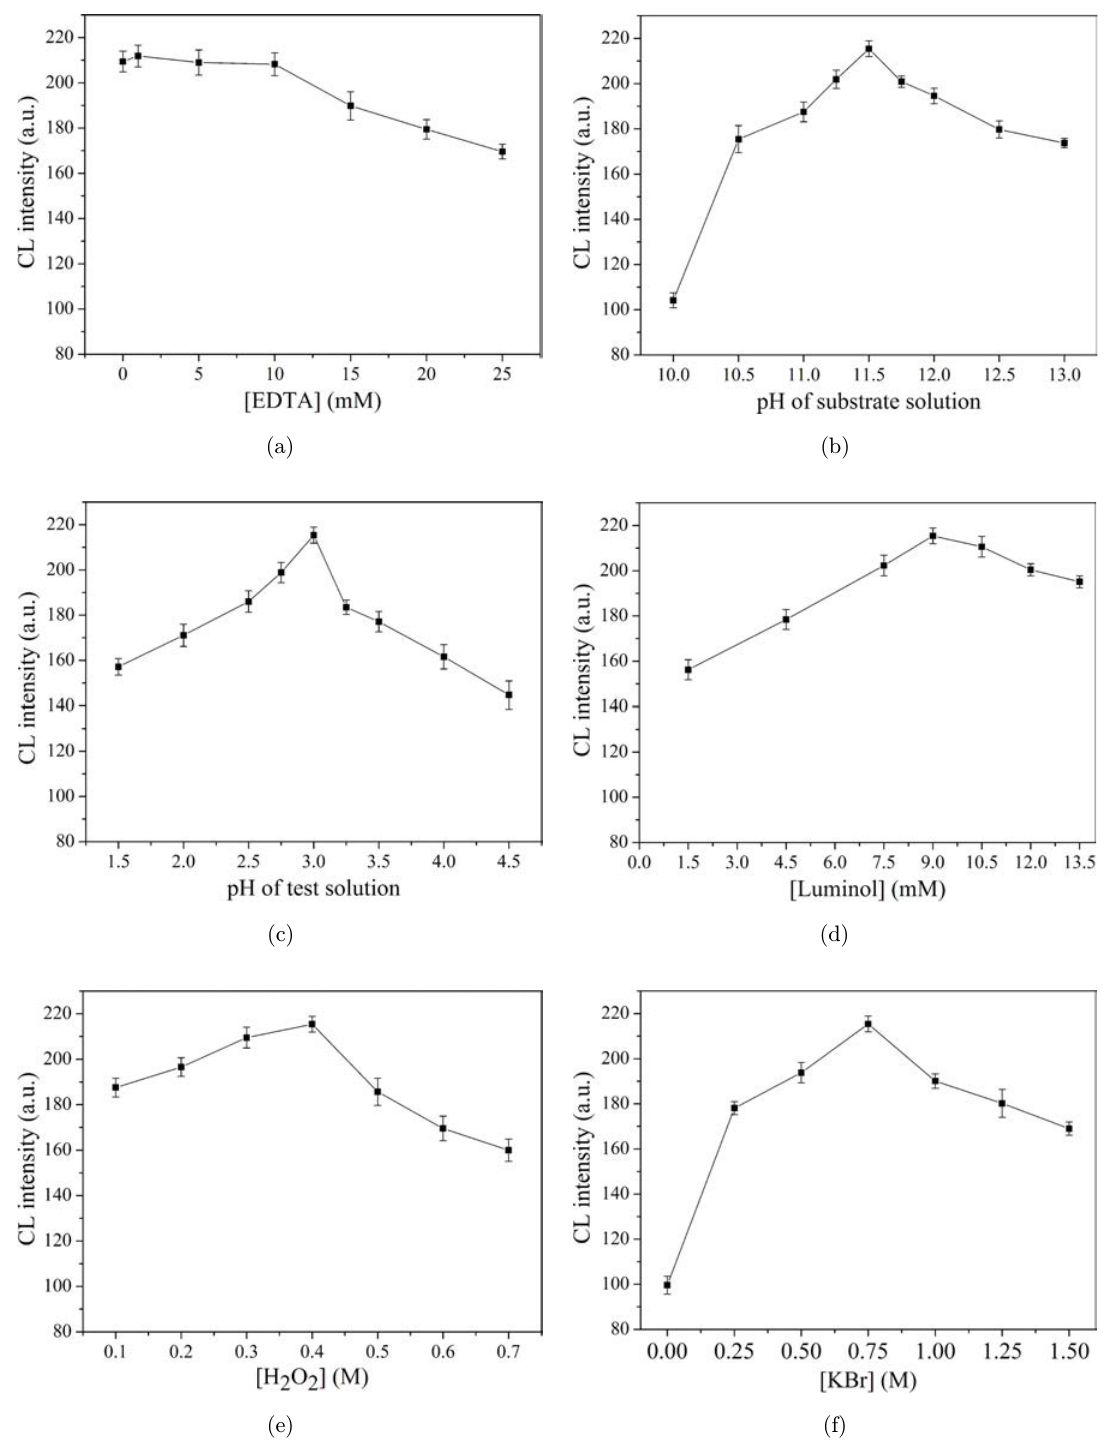
Fig. 5. Dependence of GCF-CL intensities on EDTA concentration (a), pH of substrate solution (b), pH of test solution (c), luminol concentration (d), H 2 O 2 concentration (e) and KBr concentration (f). Assay conditions: ½ EDTA (cid:5) ¼ 1 mM; pH of substrate solution/test solution ¼ 11 : 50/3.00; ½ luminol (cid:5) ¼ 9 mM; ½ H 2 O 2 (cid:5) ¼ 0 : 4 M; ½ KBr (cid:5) ¼ 0 : 75 M; inclination angle ¼ 30 (cid:2) ; volume of sub- strate solution/test solution ¼ 30 (cid:2) L/30 (cid:2) L. The error bar is the standard error from eight independent